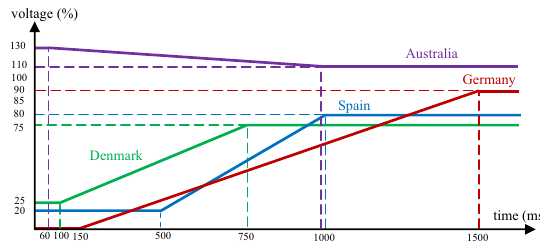
Fig. 1 FRT requirements of the network codes in several countries [21]